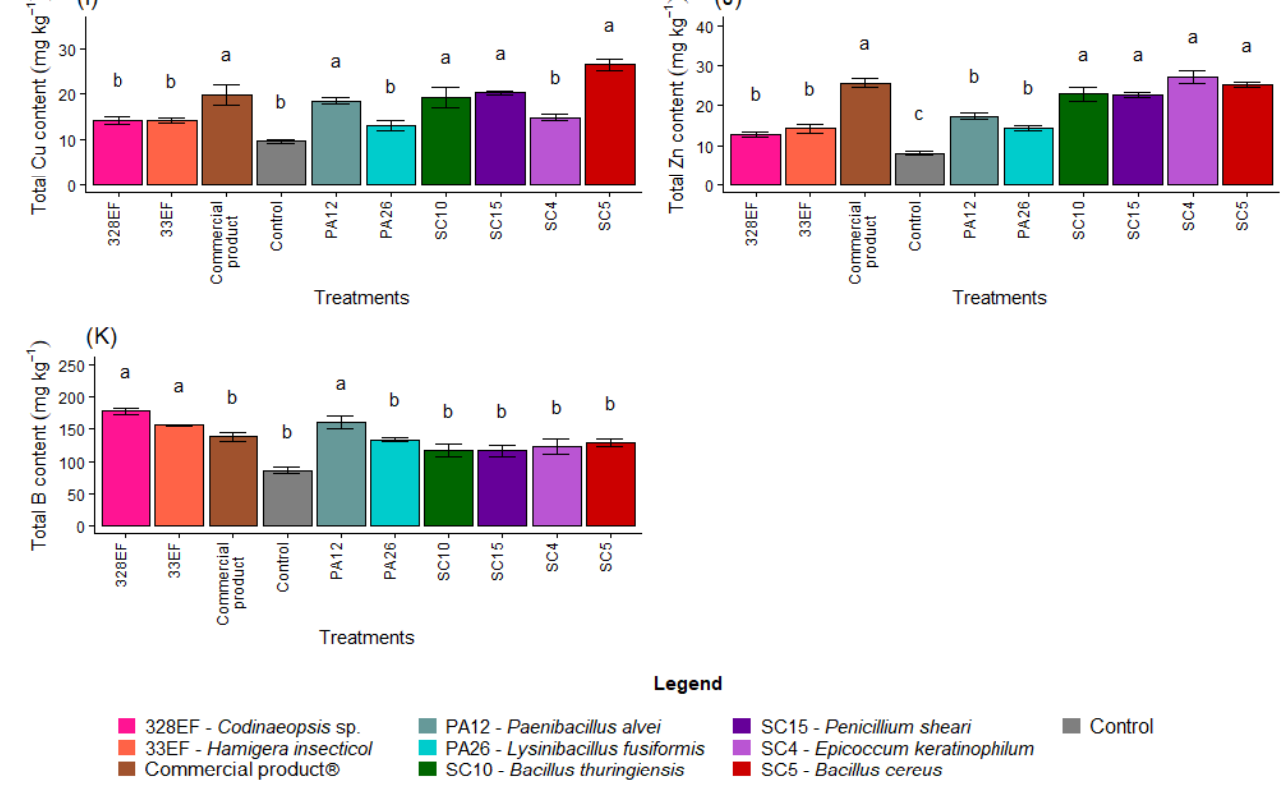
Figure 4. Total content of the macronutrients N ( A ), P ( B ), K, ( C ), Ca ( D ), Mg ( E ), and S ( F ) and of the micronutrients Fe ( G ), Mn ( H ), Cu, ( I ), Zn ( J ), and B ( K ) in soybean ( Glycine max) plants inoculated with fungal and bacterial strains isolated from Hymenaea courbaril and Butia purpurascens and grown in a controlled greenhouse system. Means followed by the same letter were not significantly different using the Scott – Knott test at 0.05% probability.